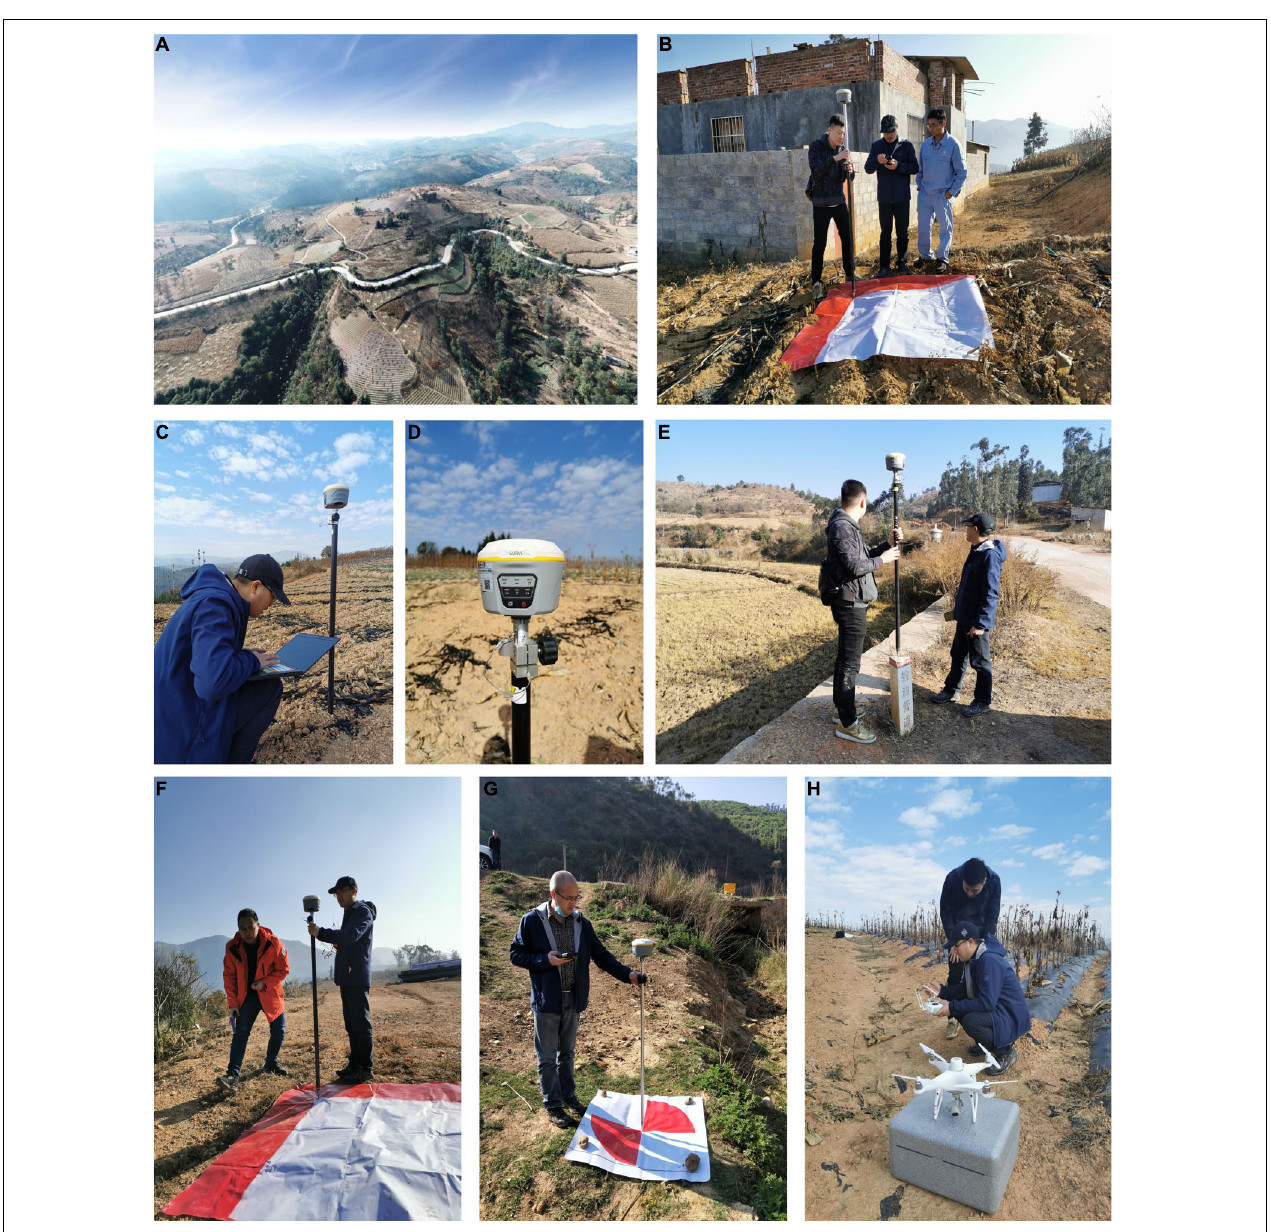
FIGURE 3 | UAV phase control point layout and measurement operations: (A) UAV photo of the study area, (B–G) Control points measurement, and (H) Phantom 4 RTK UAV used in this study.